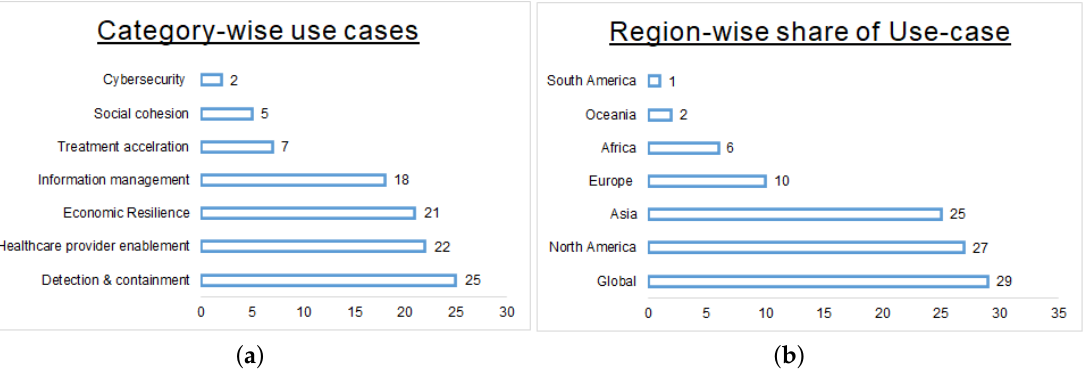
Figure 1. New technologies in response to COVID-19: ( a ) category-wise use cases, ( b ) stats of collaborative and interconnective response across the globe (adopted from https://www.weforum. org/agenda/2020/08/5-technology-advancements-during-covid-19-wearables-ai/, accessed on 4 December